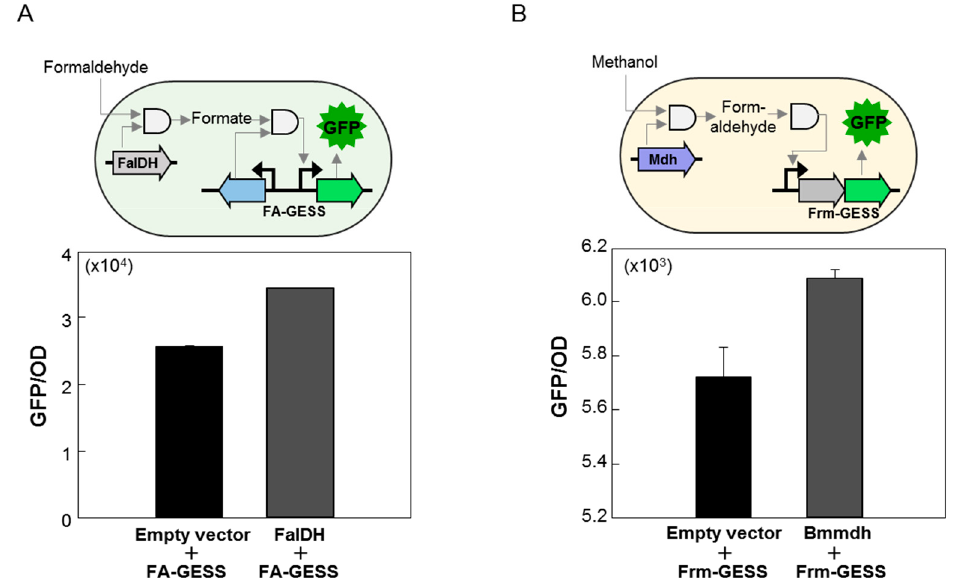
Figure 5. Application study of C1 biosensors. ( A ) Graphical representation of the application of the C1 biosensors with sequential enzymes. ( B ) Activities of the formaldehyde dehydrogenase (FalDH) and methanol dehydrogenase (Bmmdh) were measured using the respective biosensor cells. Three hours after induction with the IPTG (1.0 mM), formaldehyde (100 μ M) or methanol (200 mM) were added, and then the fluorescence signal was measured. The solid black arrows represent promoter site. The gray arrows indicate the operational path of biosensor when the substrates and enzymes was added.